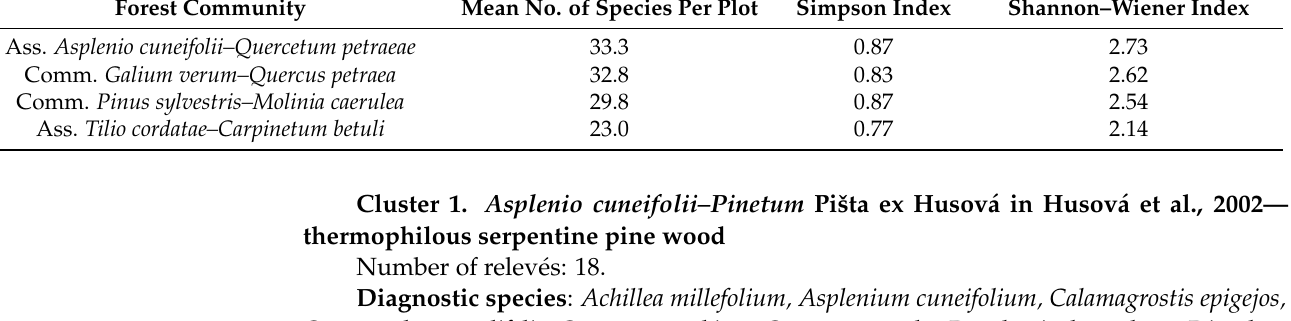
Table 1. Selected biodiversity indicators calculated for forest communities on serpentinites in SW Poland (Sudetes Foreland). Forest Community Mean No. of Species Per Plot Simpson Index Shannon–Wiener